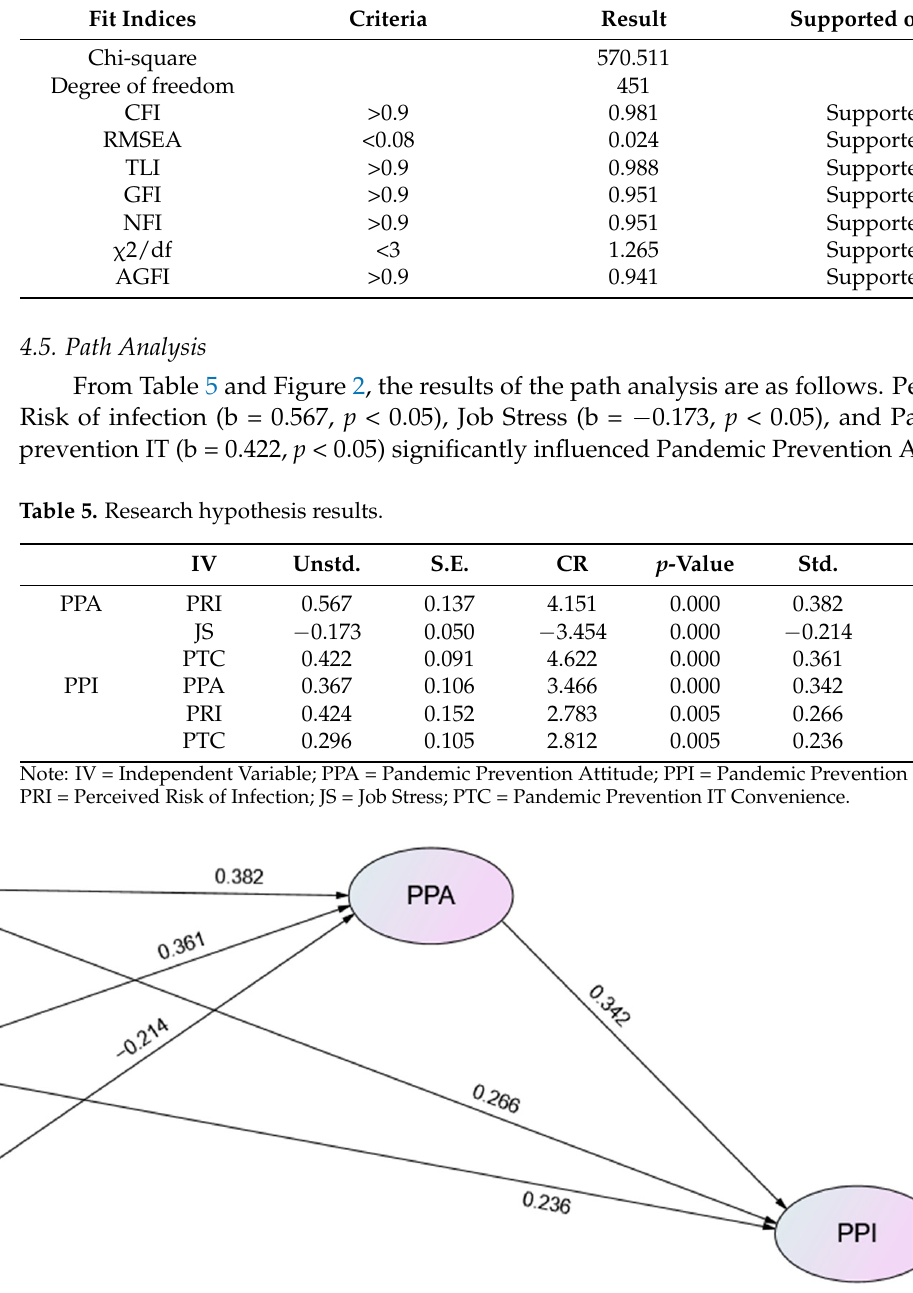
Table 4. Goodness of fit index.